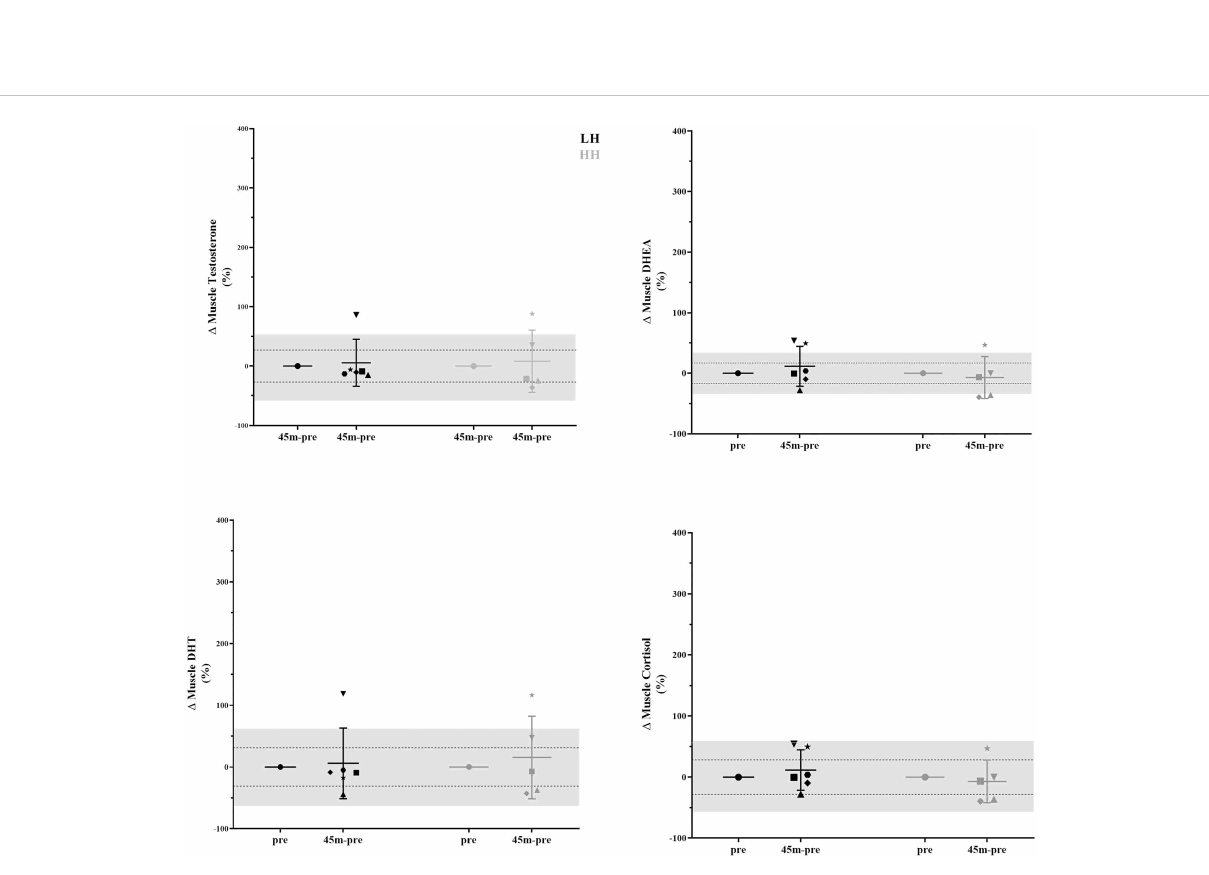
FIGURE 4 Delta changes in muscle steroid concentrations pre-LH and HH protocols and 45 min postexercise. The gray area represents two times the typical error (positive and negative), and the dotted lines represent the typical error (positive and negative). Each symbol represents one subject.